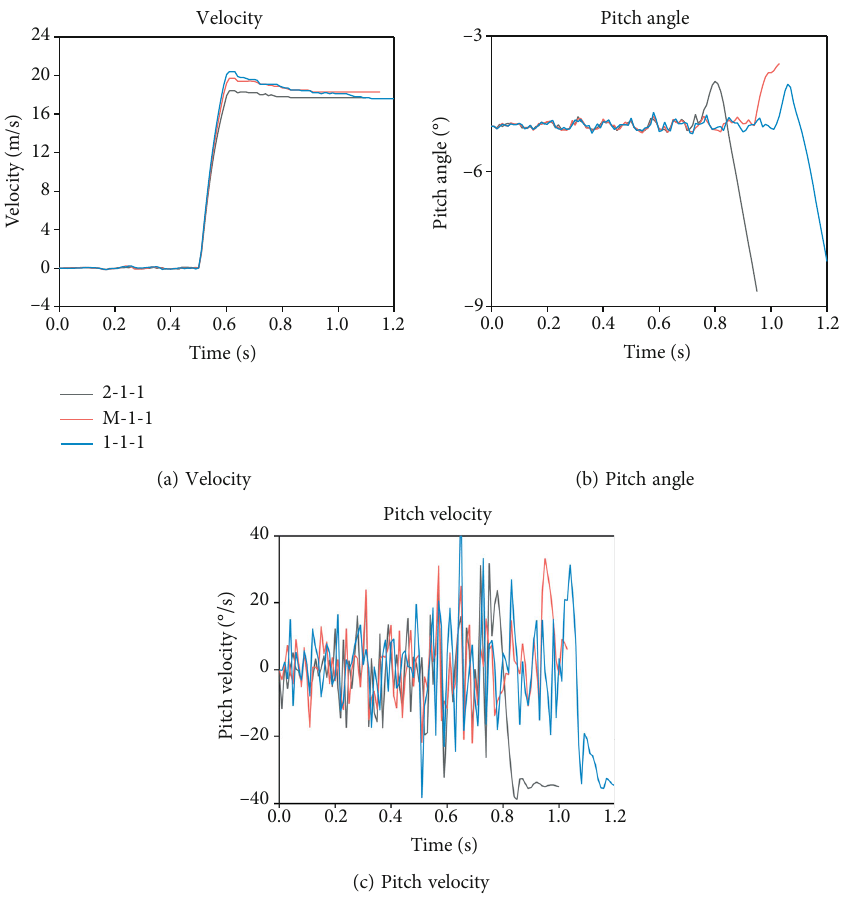
Figure 14: Comparison of missile movement under sliding